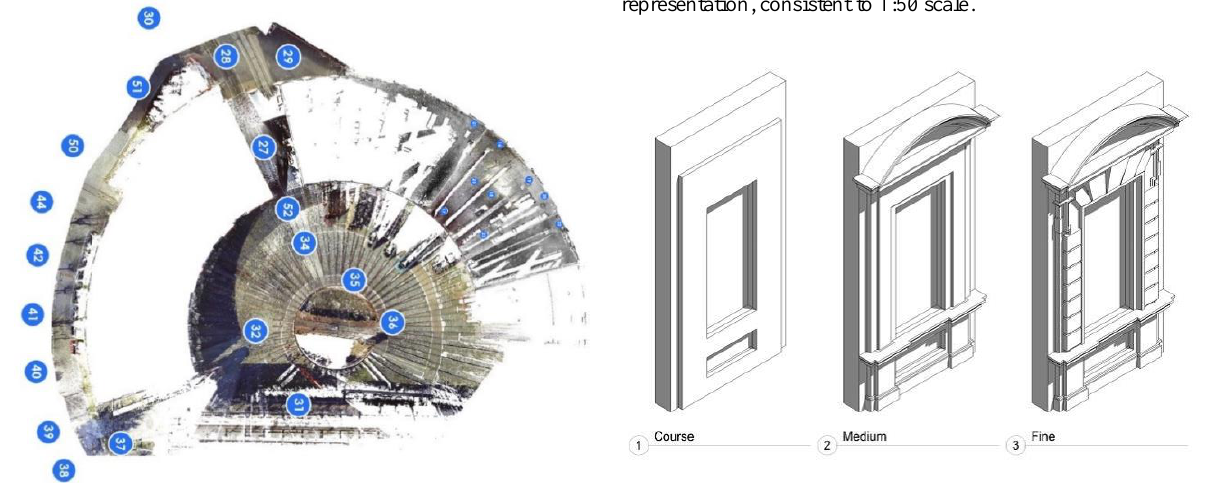
Figure 8. 3D modelling of the same building component according to several GRAphic DEtails